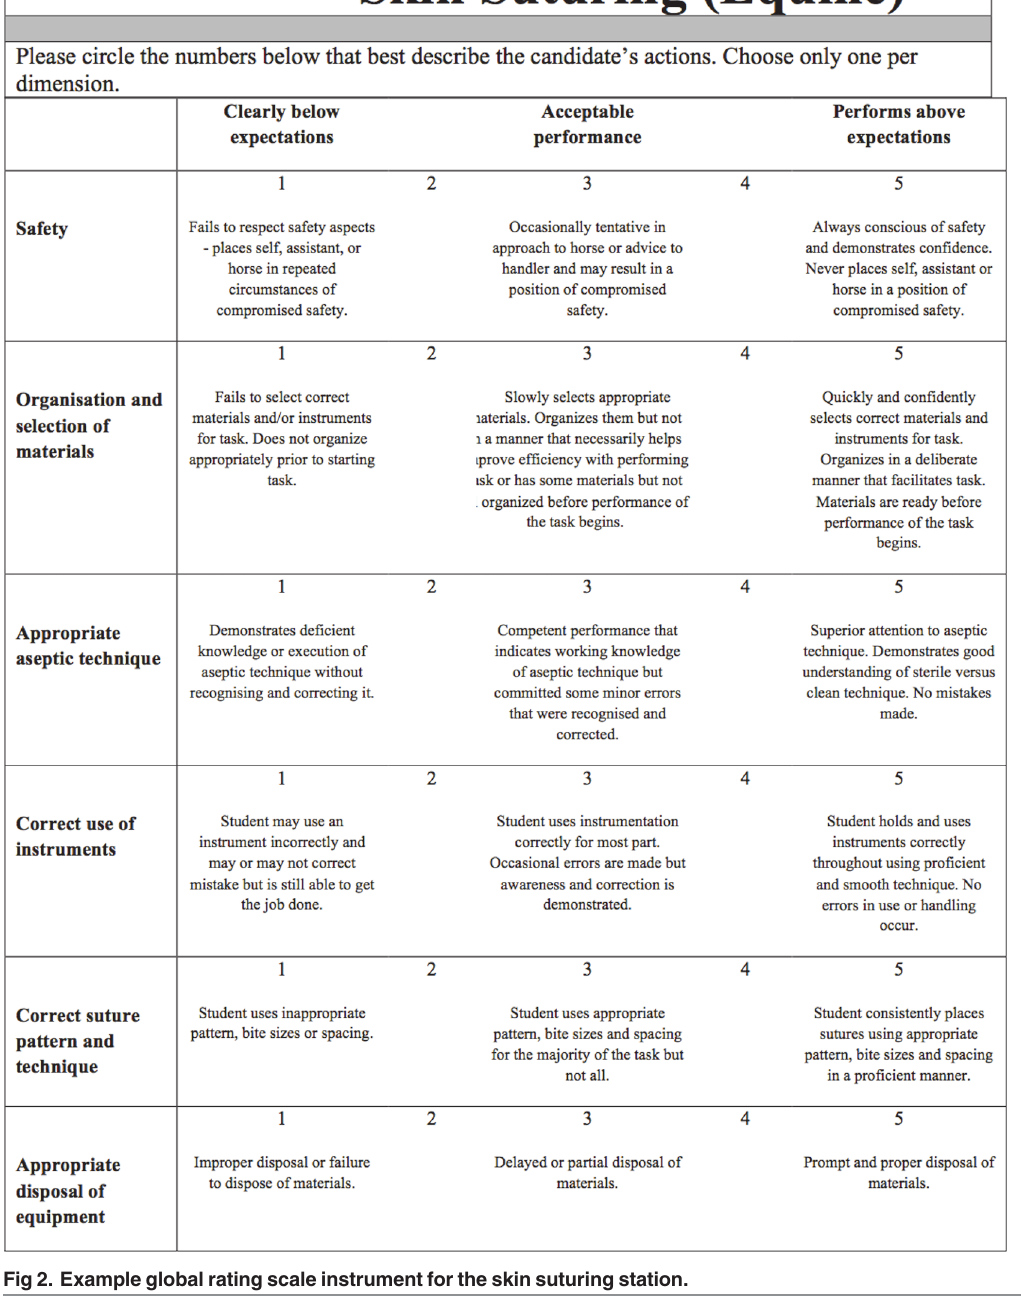
Fig 2. Example global rating scale instrument for the skin suturing station.